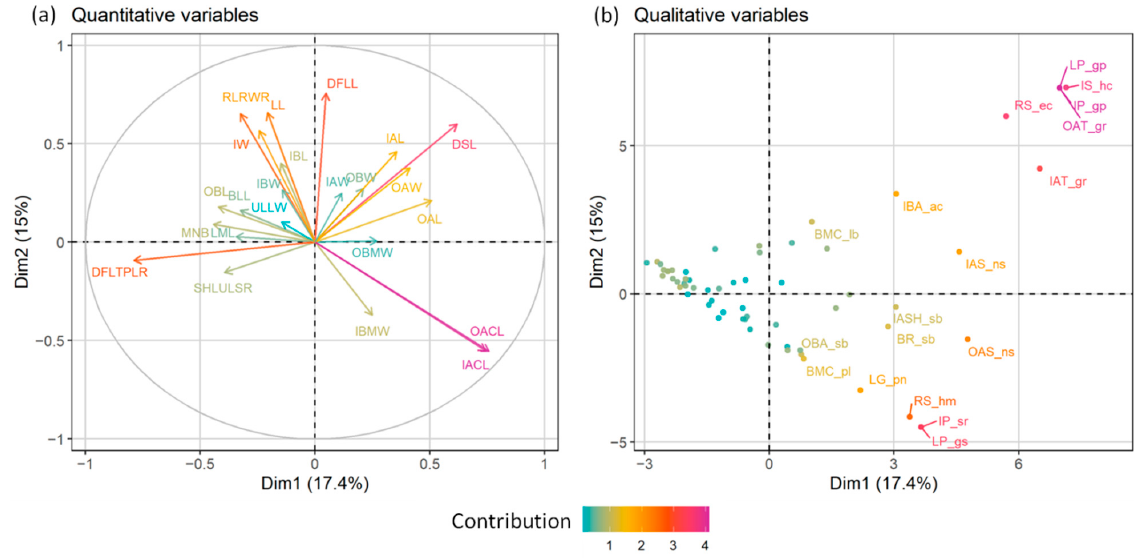
Figure 3. Relative contribution of the morphological characters to the PCA of Figure 1.